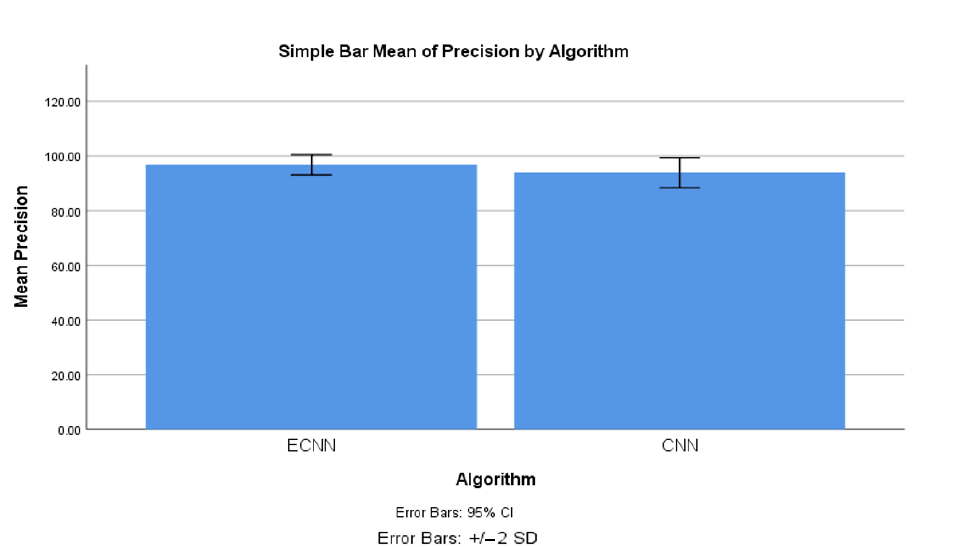
Figure 8. Mean precision comparison between ECNN and CNN with confidence interval 95% and standard deviation ±2.